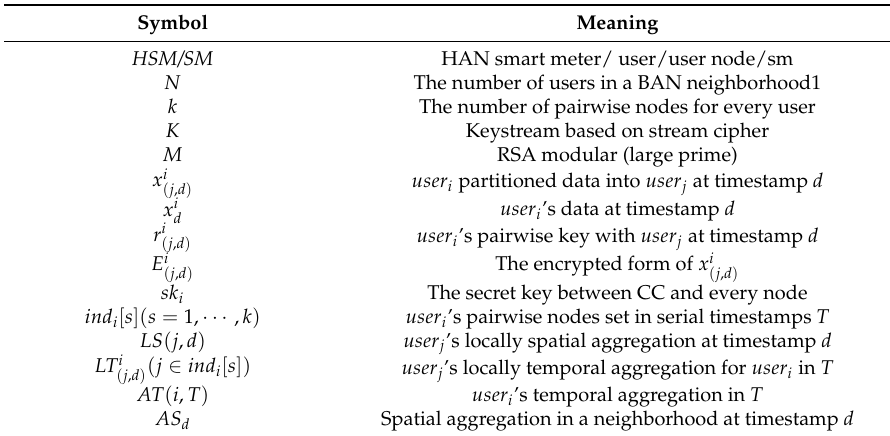
Table 1. Notations in the